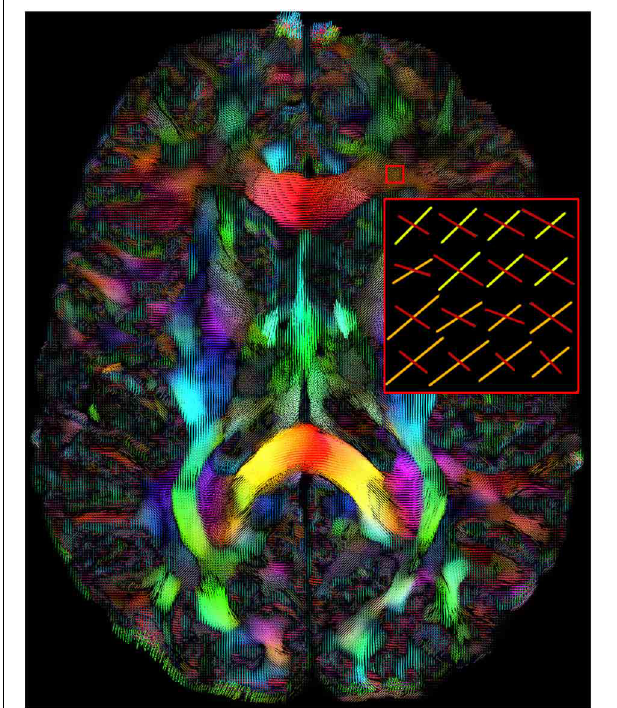
FIGURE 1 | Maxima map of upsampled fODFs showing multiple directions at each voxels. The color code is a mapping of their local coordinates ( x , y , z ) to the red-green-blue channels [R, G, B]. The length of the maxima can also be adjusted interactively by the user. (HC